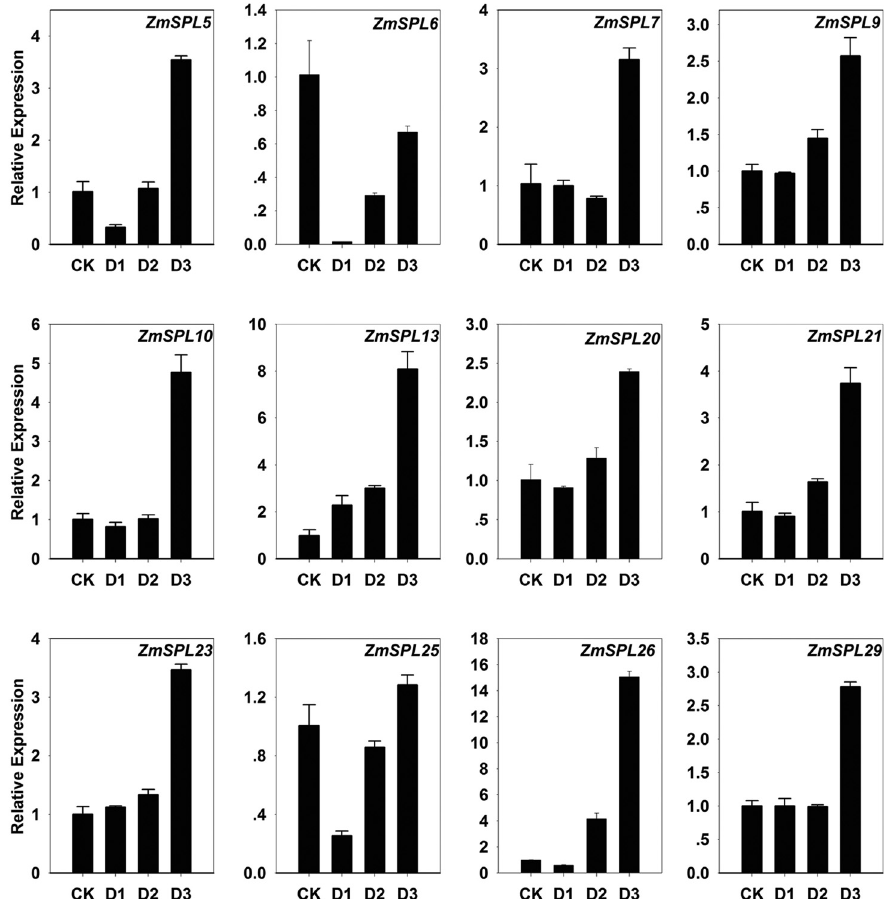
Figure 9 - Expression patterns of 12 miR156 targeted ZmSPLs under drought stress. CK: normal plant; D1: slight stress; D2: moderate stress; D3: severe stress. Shown are means (cid:5)